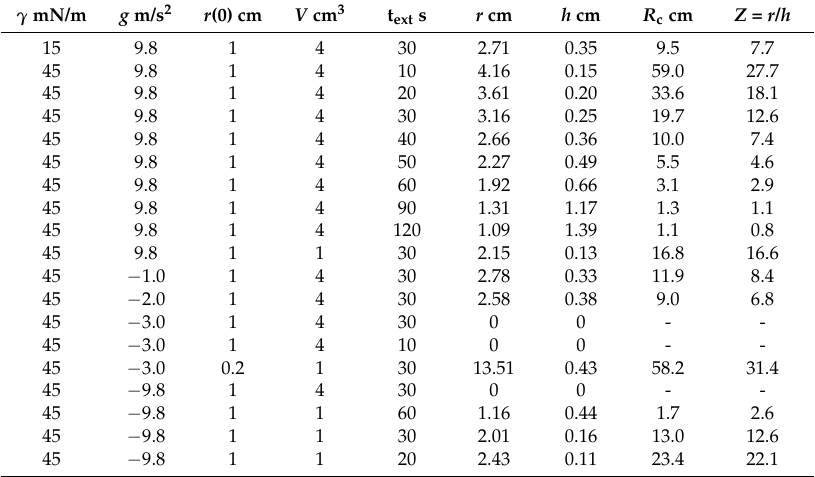
Table 2. Simulation